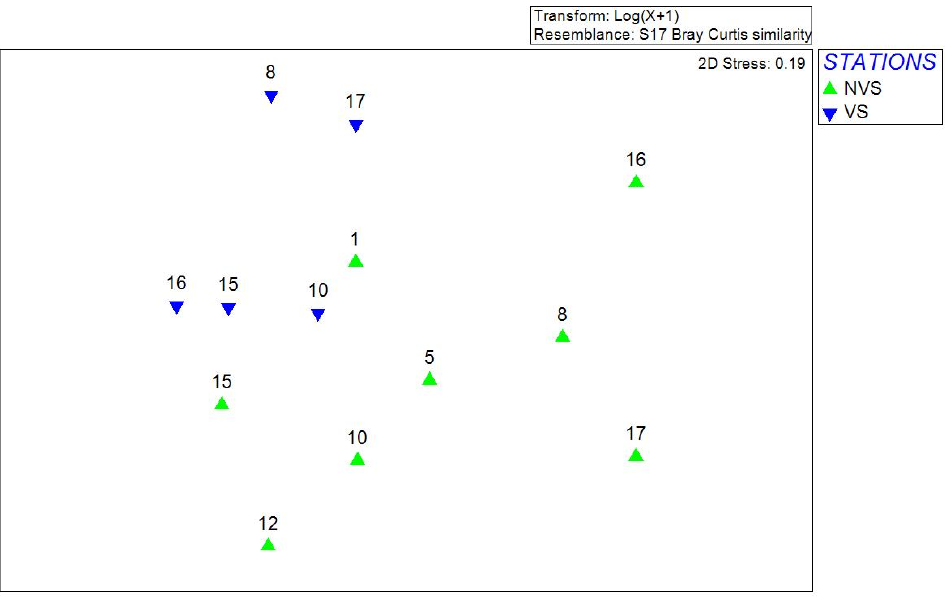
Figure 6. MDS plot applied to only 2017 samples gathered on vegetated (VS) or non-vegetated (NVS) sediments.